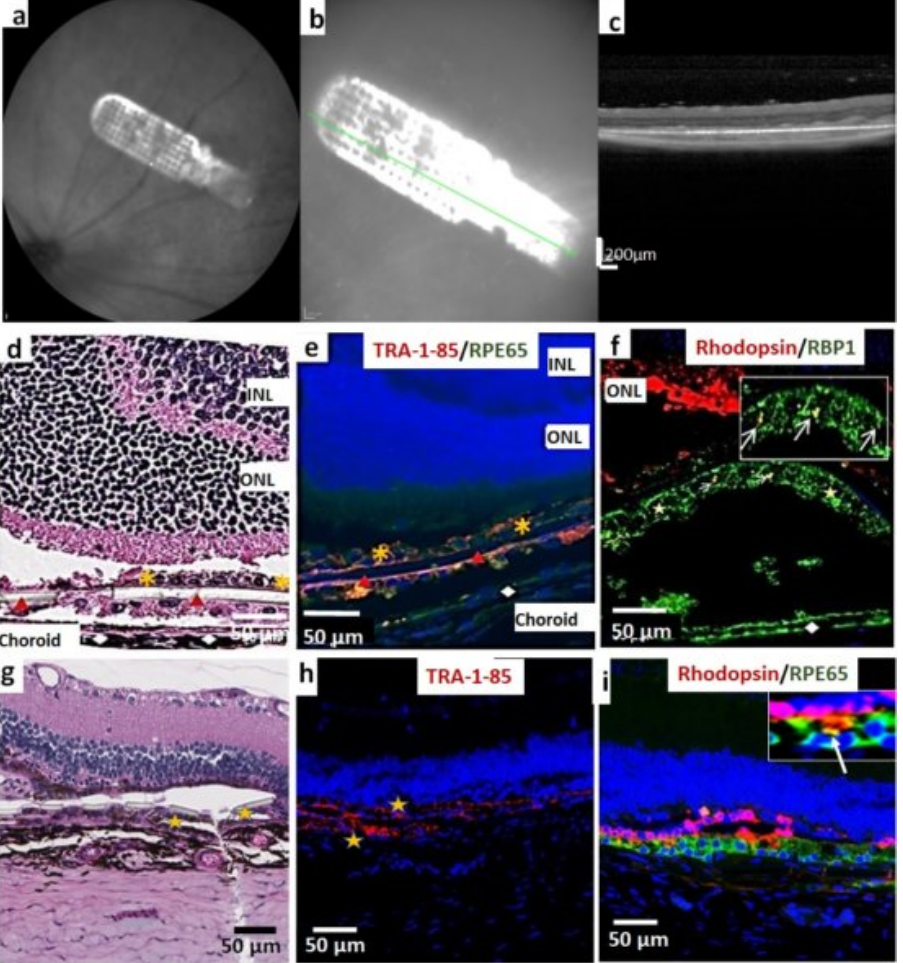
Figure 2. Short-term assessment of iPSC-RPE implant survival and functionality, in immunodeficient RCS rats. ( a ) iPSC-RPE implants observed during fundus examination of immunodeficient RCS rats at 1 month post-implantation, ( b ) enlarged view, ( c ) vertical OCT b-scan image through the transplant area, ( d ) HE image showing subretinal implant placement. The choroidal layer that appears to be separated from the remaining retina is considered a histologic artifact. Yellow asterisk indicates iPSC-RPE cells; Red arrow heads indicate the parylene membrane ( e ) transplant is identified by TRA-1-85 (human specific marker, red) and RPE65 (green) expression; Red arrowhead indicates the parylene substrate; white rhombus represents endogenous rat RPE, yellow asterisk indicates RPE on Parylene membrane ( f ) Rhodopsin (red) and retinol-binding protein (RBP1, green) staining to demonstrate that implanted iPSC-RPE can phagocytose photoreceptor outer segments (white arrows). Inset is a higher magnification of the above area. Red arrowhead indicates the parylene substrate; white rhombus represents endogenous rat RPE; ( g ) HE image showing subretinal implant 4 months after transplantation; ( h ) transplant at 4 months is identified by TRA-1-85 (human specific marker, red) ( i ) Rhodopsin (red) and RPE 65 (green) staining were used to show that implanted iPSC-RPE can phagocytose photoreceptor outer segments at 4 months after transplantation. Inset is a higher magnification of the transplant area indicating phagocytosis (white